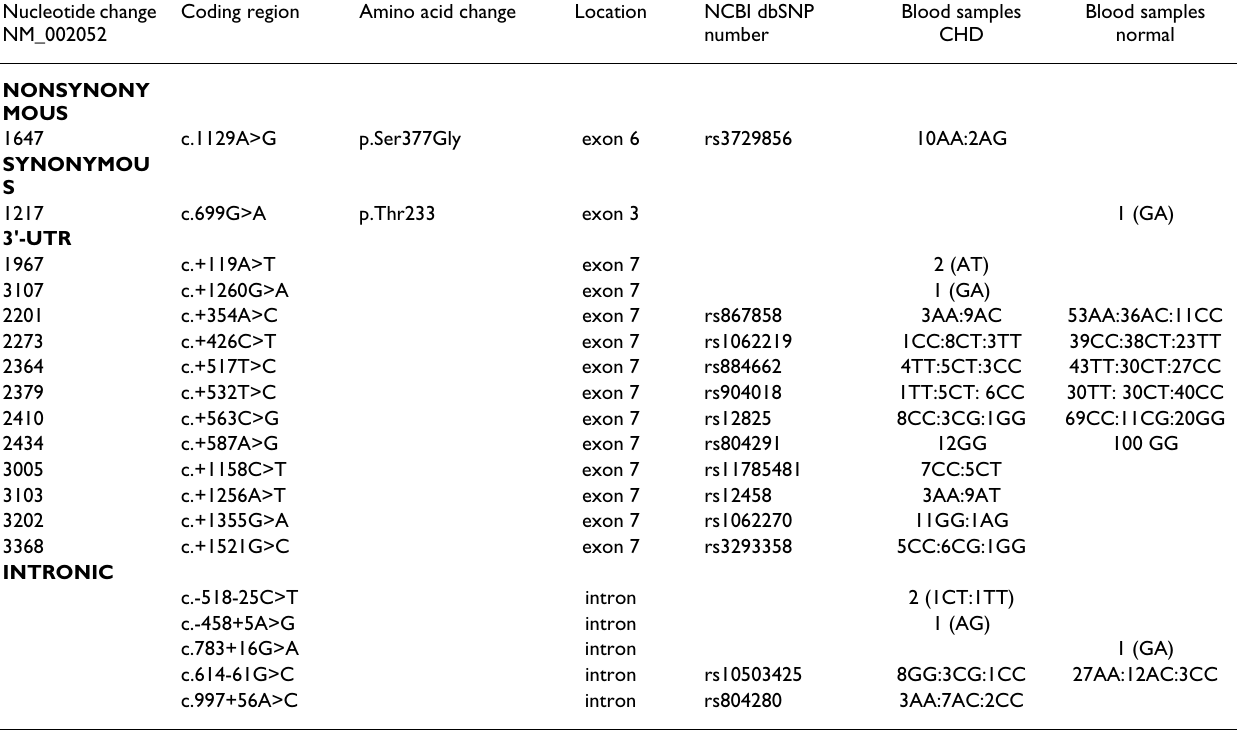
Table 4: Summary of GATA4 sequence variations in blood samples Nucleotide change